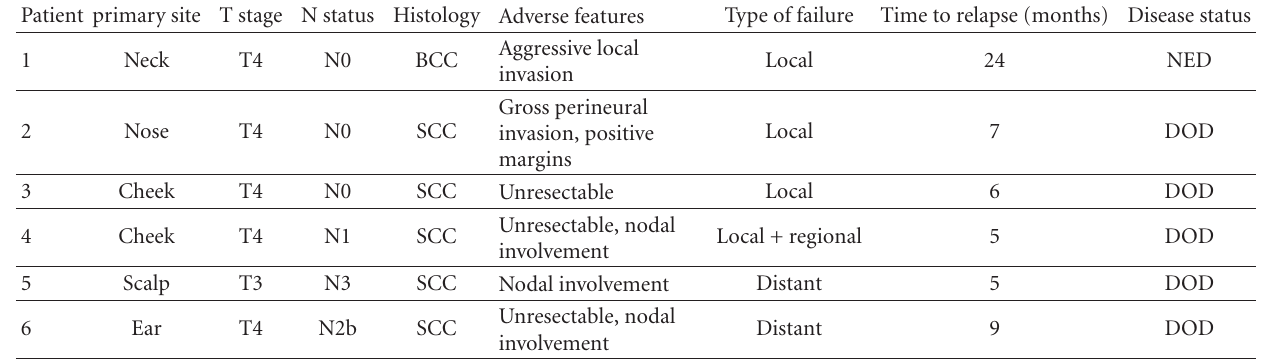
Table 4: Patterns of failure in chemoradiotherapy